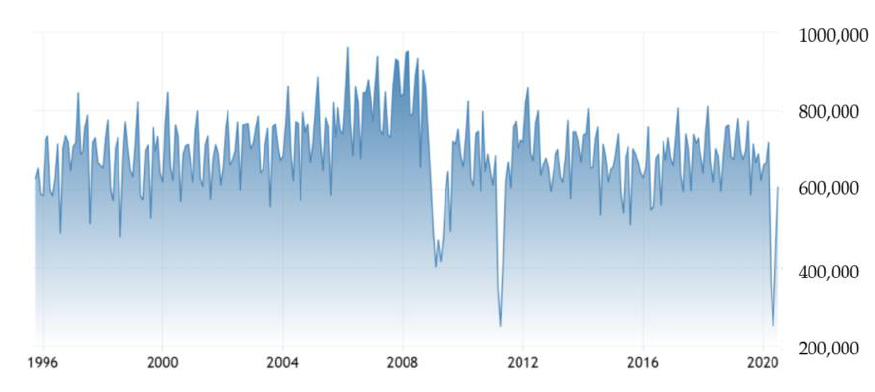
Figure 3. Production of Japanese vehicles from 1996 to 2020 [17].